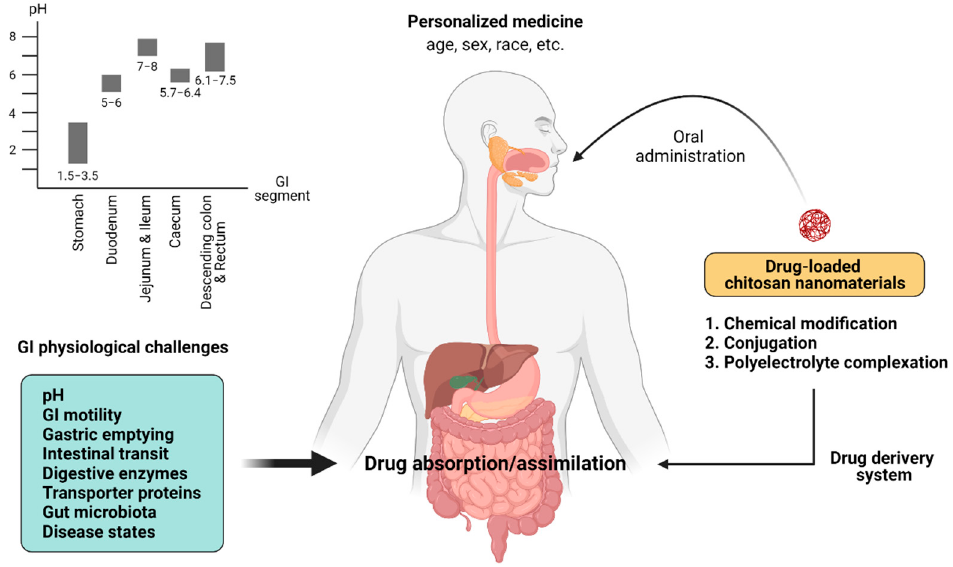
Figure 1. The schematic illustration of the GI physiological barriers affecting drug absorption. When one orally takes the drug-loaded chitosan nanomaterials (e.g., chitosan-based nanoparticles with chemical modification, conjugated chitosan, and chitosan-based polyelectrolyte complex), they encounter GI physiological challenges, including a variable pH along the GI tract, GI motility and gastric emptying, intestinal transit, digestive enzymes, transporter protein expression, gut microbiota, and disease conditions. The GI physiological challenge can be influenced by aging, gender, and ethnicity. Created with